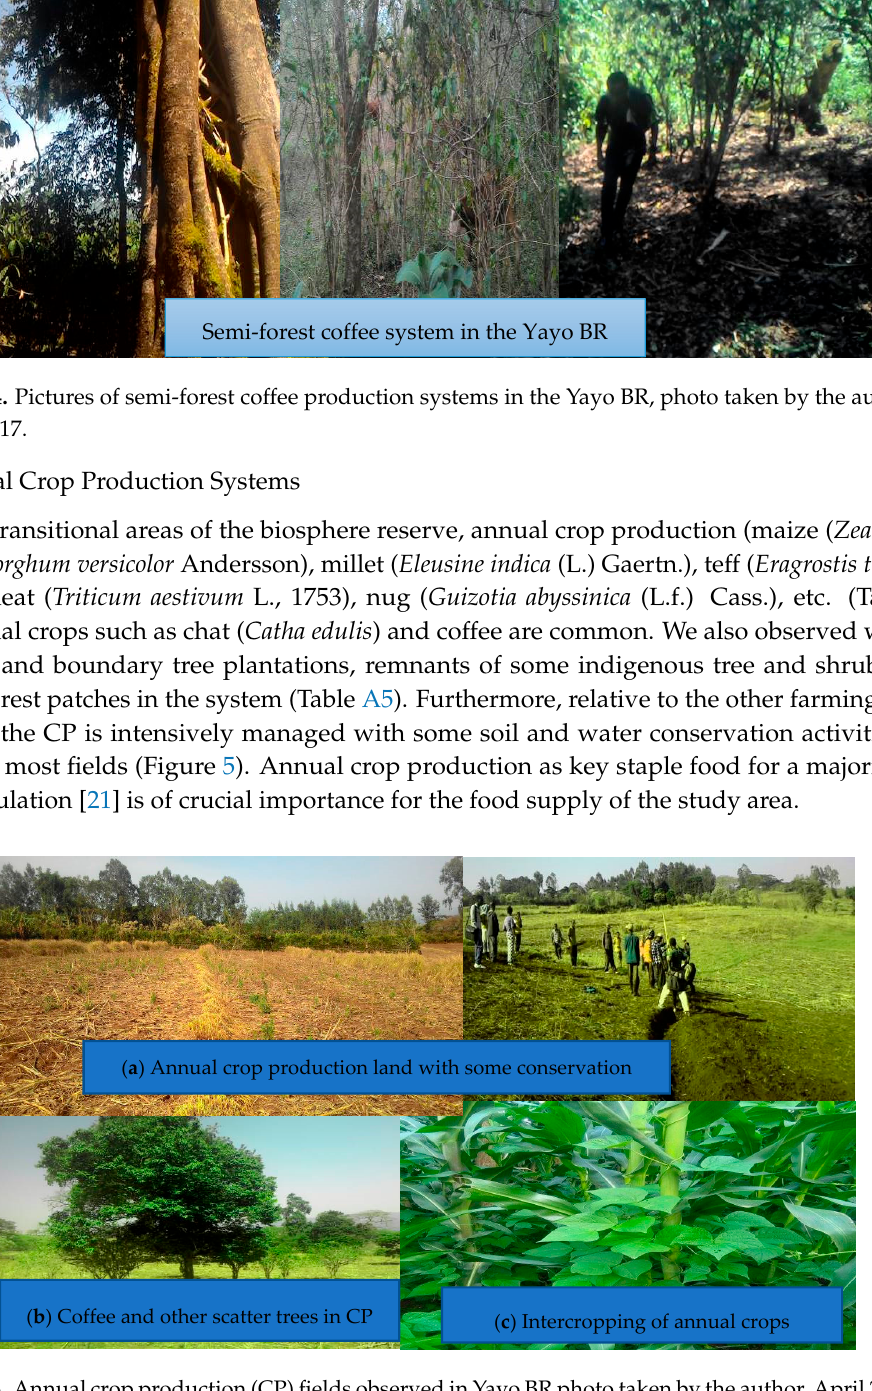
Figure 5. Annual crop production (CP) fields observed in Yayo BR photo taken by the author, April